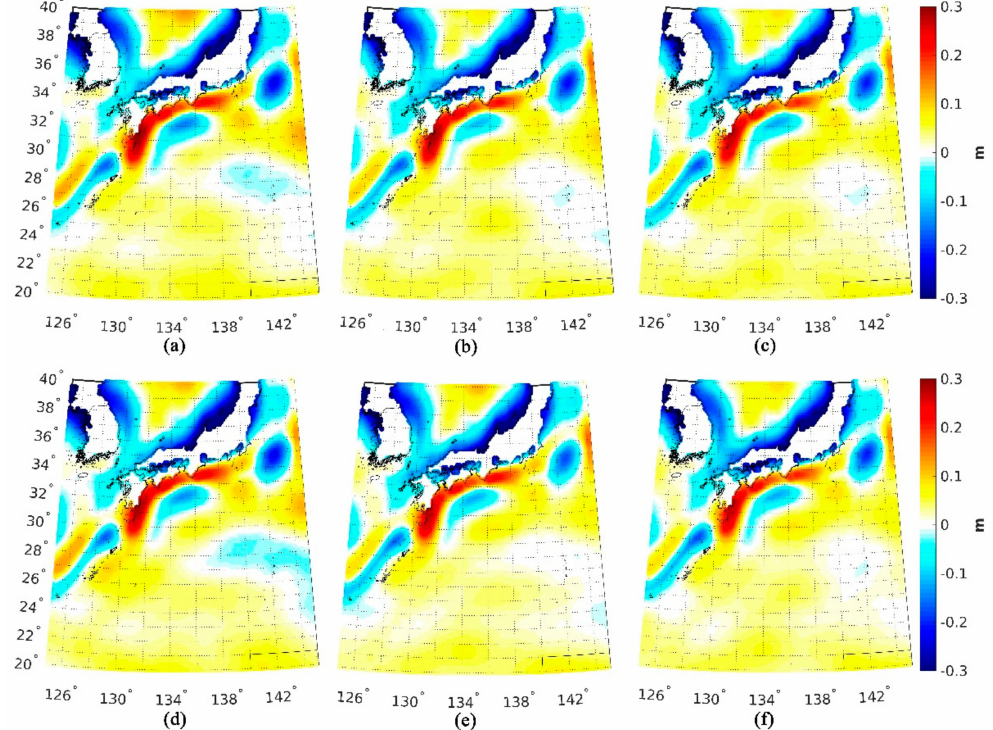
Figure 5. The differences between ( a ) DTU18DIRR4-MDT, ( b ) DTU18DIRR5-MDT, ( c ) DTU18DIRR6-MDT, ( d ) DTU18TIMR4- MDT, ( e ) DTU18 TIMR5MDT, ( f ) DTU18TIM R6-MDT and the reference